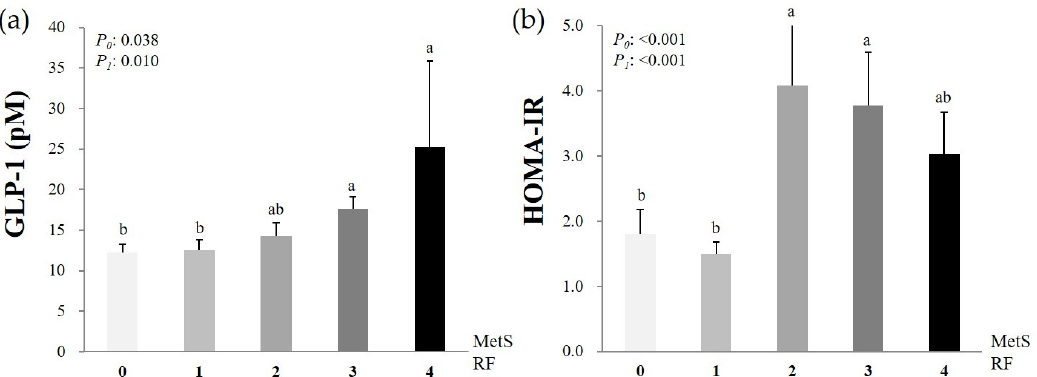
Figure 2. Circulating GLP-1 levels ( a ) and HOMA-IR scores ( b ) according to the number of MetS RFs. Mean ± SD, tested after log transformation of the data; tested by the one-way analysis of variance with the Bonferroni method and by the general linear model after adjustment for confounding factors (age, total calorie intake, cigarette smoking, alcohol drinking, and/or menopausal status); P 0 : Unadjusted p -value, P 1 : P -value adjusted for confounding factors. Values sharing the same alphabet indicate no statistically significant differences among them. GLP-1: Glucagon-like peptide-1; HOMA-IR: Homeostatic model assessment of insulin resistance; MetS RFs: Metabolic syndrome risk factors. Zero MetS RFs, n = 61; 1 MetS RF, n = 33; 2 MetS RFs, n = 27; 3 MetS RFs, n = 16; 4 MetS RFs, n =